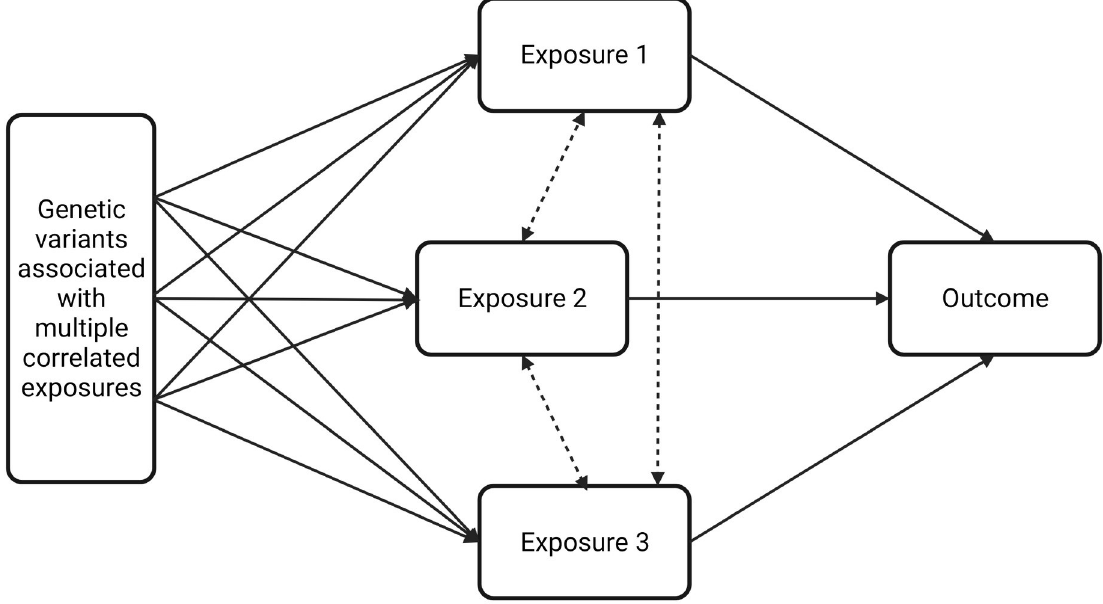
Fig 1. Schematic representation of multivariable Mendelian randomization